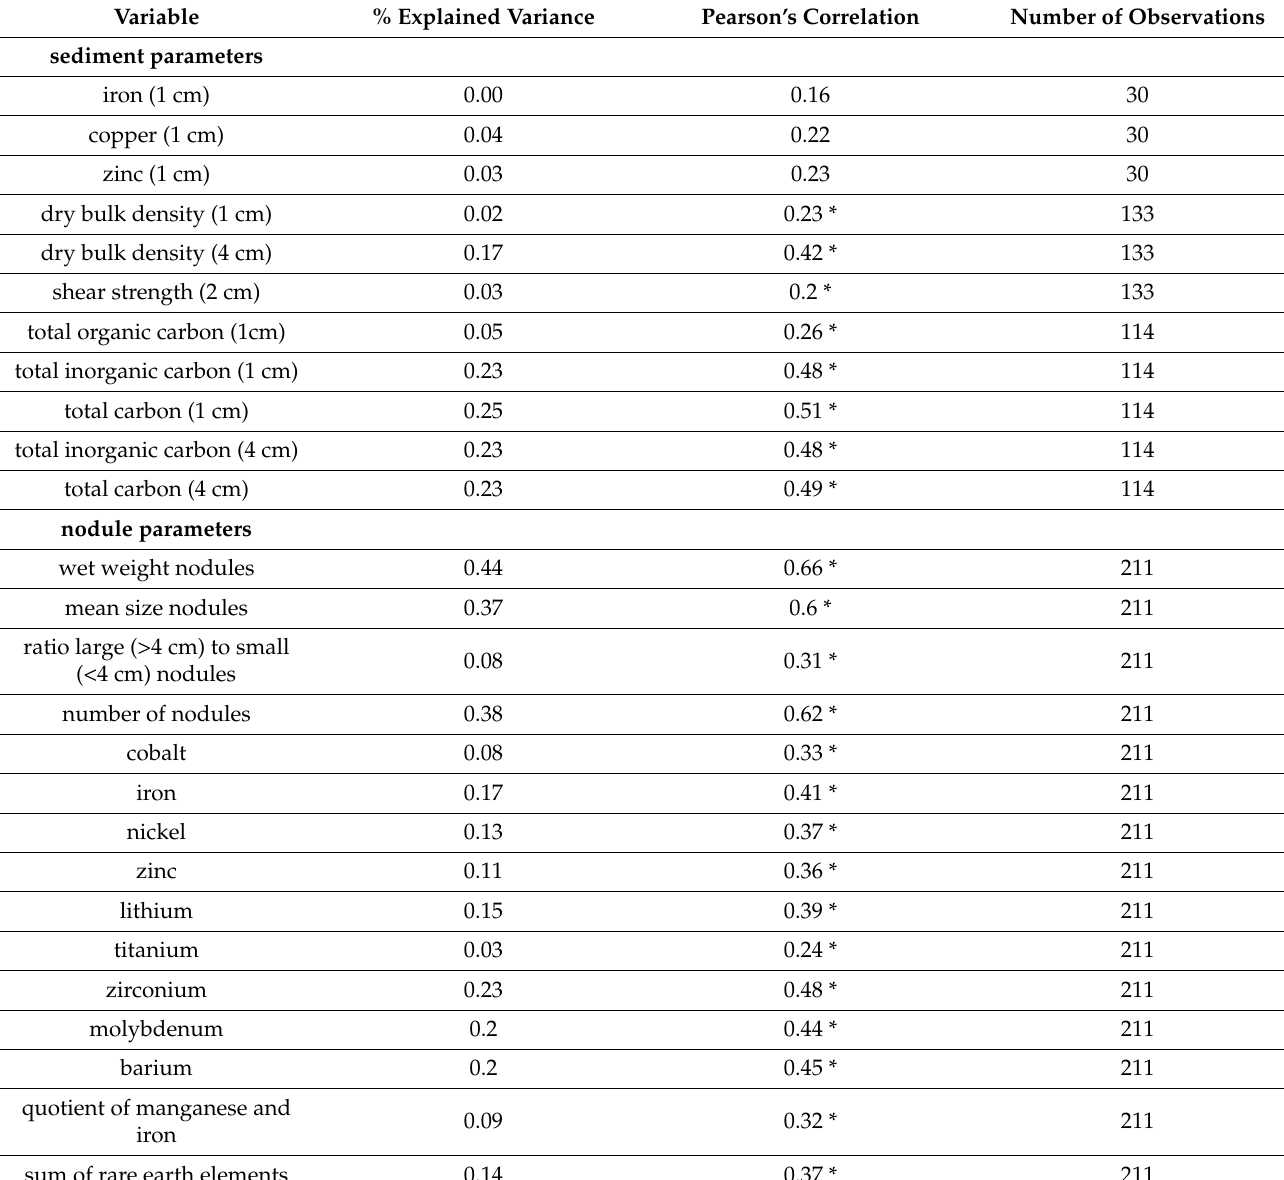
Table 1. Model evaluations of the random forest regressions computed for the sediment and nodule characteristics used for distribution modelling of meiofauna according to the percentage of explained variance and Pearson’s correlation (* indicating significance). The number of observations that could be integrated into the model is given. Elements refer to their concentration in the sediment and the nodules, respectively. Centimetres refer to the sampling depth in the